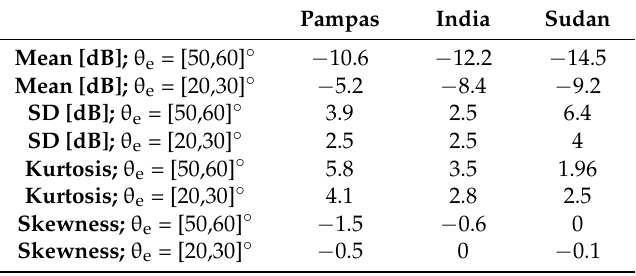
Figure 7. Histograms of the CyGNSS reflectivity Γ LHCP,CyGNSS over the selected target areas [( a , b ) Argentinian Pampas, ( c , d ) India, and ( e , f ) Sudan] for ( a , c , e ) θ e = [20,30] ◦ , and (b,d,f) θ e = [50,60] ◦ . Table 4. Statistics (mean, standard deviation SD, kurtosis, and skewness) of the CyGNSS reflectivity Γ LHCP,CyGNSS distributions over the selected target areas (Argentinian Pampas, India, and Sudan).